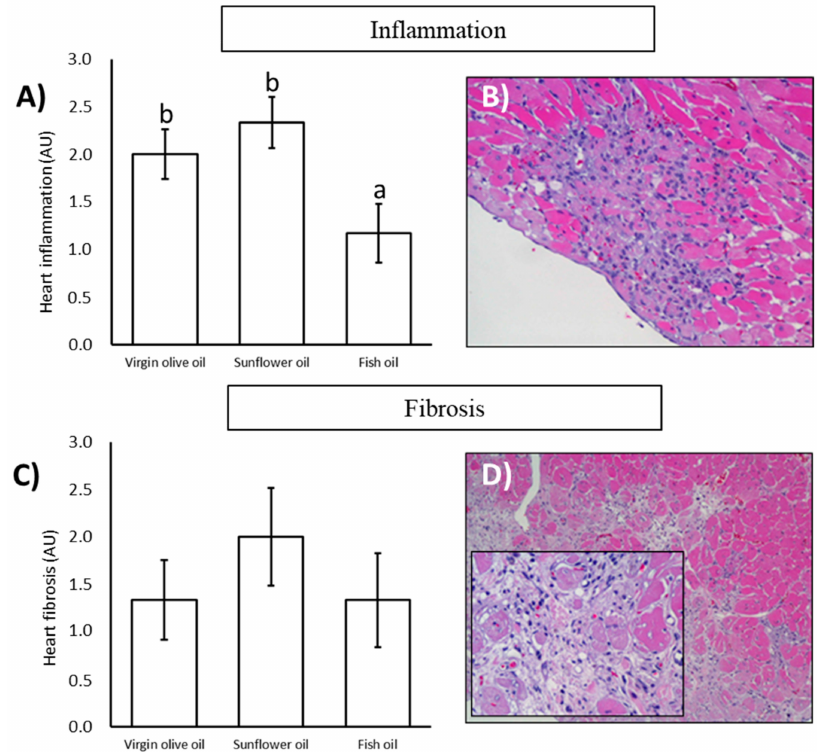
Figure 2. Inflammation and fibrosis in the heart of 24-month-old rats. ( A ) Data of semi-quantitative determination data of heart inflammation of rats fed on virgin olive oil, sunflower oil or fish oil. n = 6. ( B ) Representative image of a histological section of heart showing patches of inflammation. H & E, 20 × . ( C ) Semi-quantitative analysis of heart fibrosis. n = 6. ( D ) Representative image of a histological section of heart showing fibrosis areas. H & E, 10 × . Insert, 20 × . For each parameter, lower-case letters, when di ff erent, represent statistically significant di ff erences ( p < 0.05) between the dietary treatments. Abbreviations: AU = Arbitrary